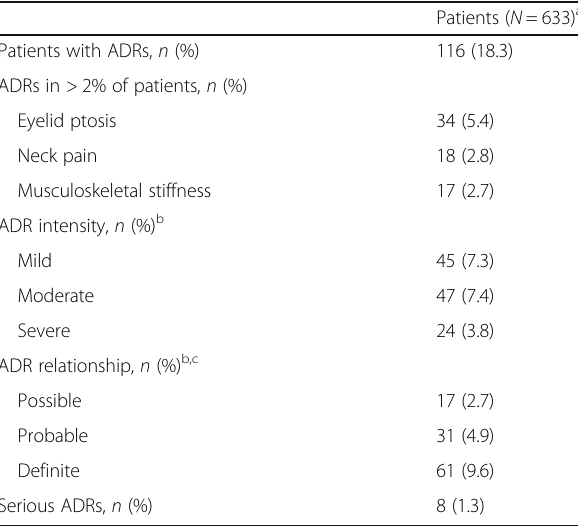
Patients ( N = 633) a